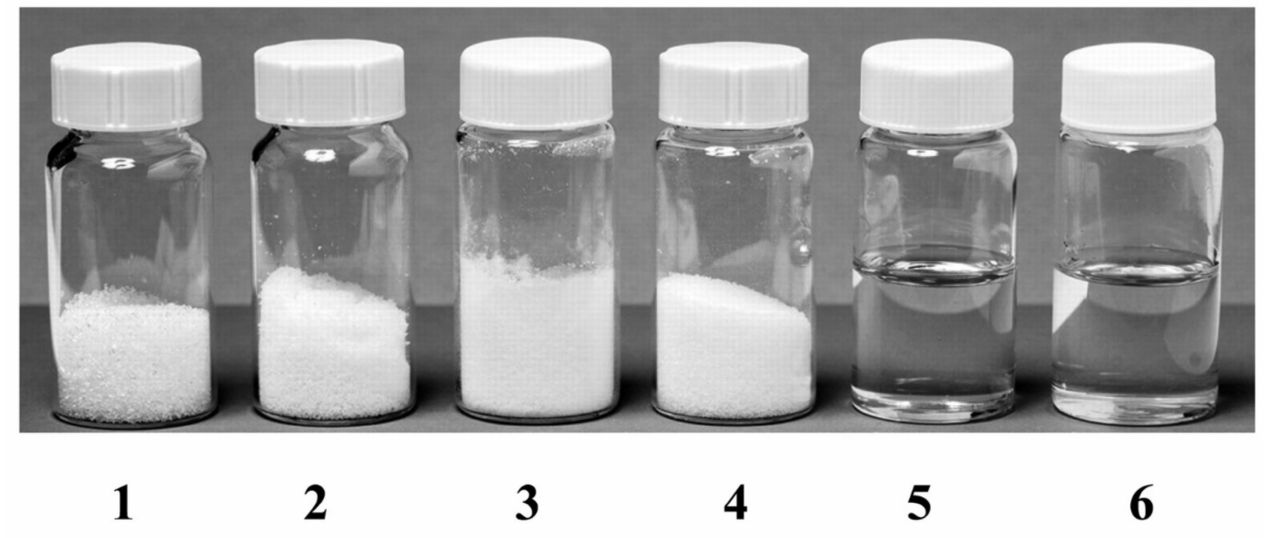
Figure 1. Typical natural deep eutectic solvents. Container 1, Sucrose; Container 2, Fructose; Con- tainer 3, Glucose; Container 4, Malic acid; Container 5, Sucrose: Fructose: Glucose (1:1:1, molar ratio); Container 6, Sucrose: Malic acid (1:1, molar ratio). The synthesized deep eutectic solvents (container 5 and 6) are liquid in form. Reprinted with permission from [49]. Copyright 2003